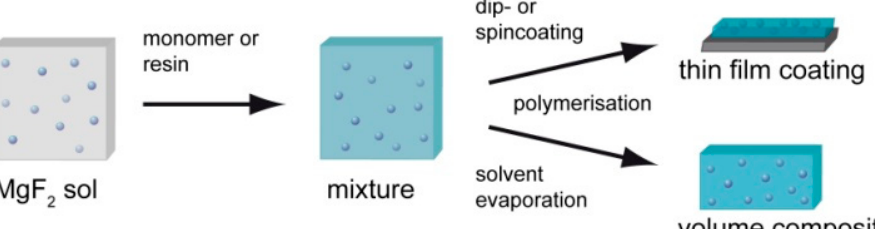
Figure 20. Scheme of composite preparation from MgF 2 sols as thin film coatings or volume composites. Reproduced from Reference [62] with the permission of the Royal Chemical Society.